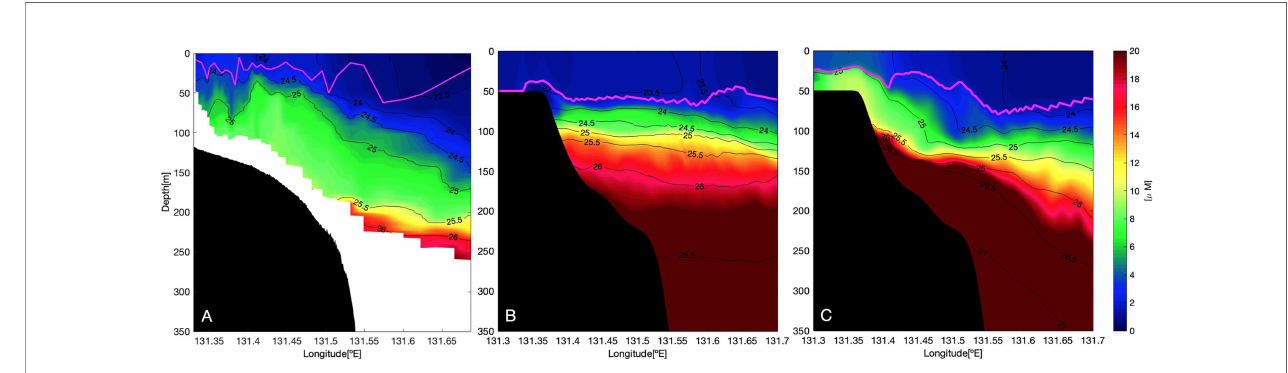
FIGURE 2 | Vertical sections, computed along the cyan line in Figure 1 , of nitrate concentration ( m M) for (A) in-situ data taken onboard in November 2018 (Nagai et al., 2019), for ROMS numerical simulation on (B) November 11 th and (C) December 20 th at hour 18:00. The black contours represent isopycnals, and the magenta line represents the mixed layer depth (MLD) where density difference is 0.125 kg m -3 from the surface. Black shapes near the bottom represent (A) acoustically detected bottom depth and (B, C)